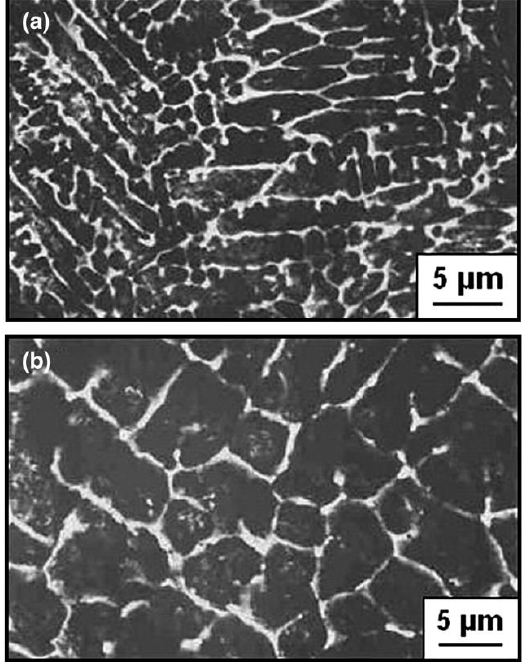
Figure 7. Scanning electron micrographs (SEMs) of the top surface of LC of Fe-Cr-Mo-Y-N-C on AISI 4140 substrate surfaces with a linear scan speed of 2.5 m/min and incident laser power of ( a ) 1.5 kW, ( b ) 2.0 kW. Reproduced with permission from [29]. Copyright Elsevier, 2008.